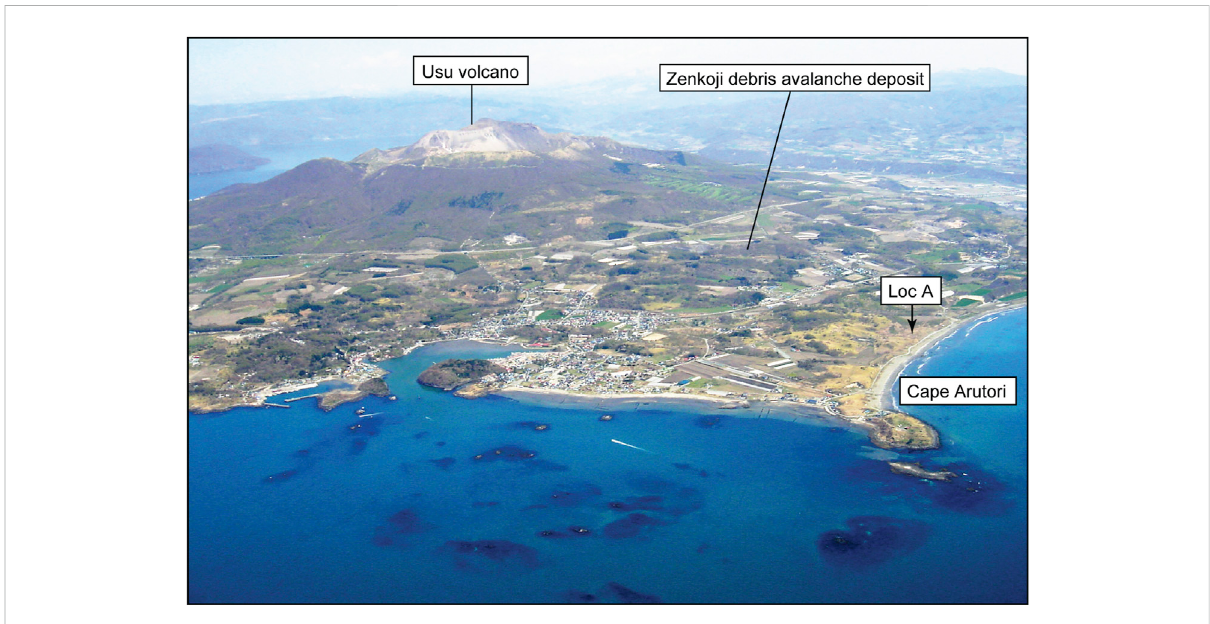
FIGURE 4 Photograph of Usu volcano and the Zenkoji debris avalanche deposit taken from the southwest. Hummocks are also recognized in the sea. Cape Arutori and locality A are indicated (see, Figure